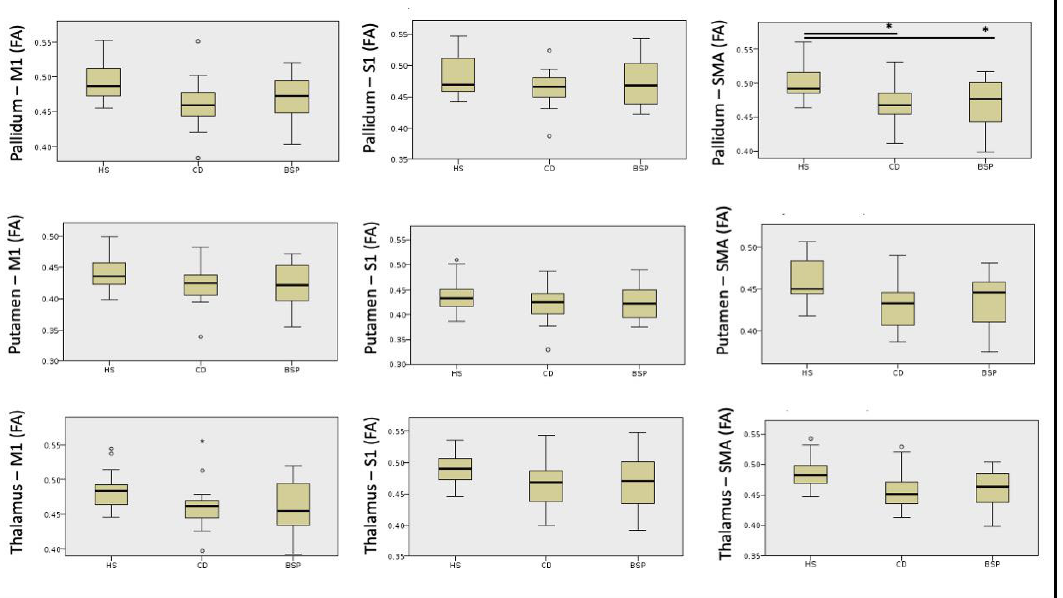
Figure 2. Differences in fractional anisotropy (FA) of cortical-subcortical white matter tracts among subjects. HS: healthy subjects; CD: cervical dystonia; BSP: blepharospasm; M1: primary motor cortex head/face region; S1: primary sensory cortex head/upper limb region; SMA: supplementary motor area. Kruskal – Wallis post hoc analysis (* p < 0.05). Circles indicates outliers.